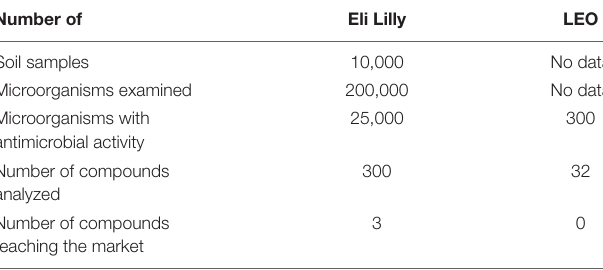
TABLE 3 | Comparison of natural product antibiotic screenings by Eli Lilly and LEO 1949–1959 a